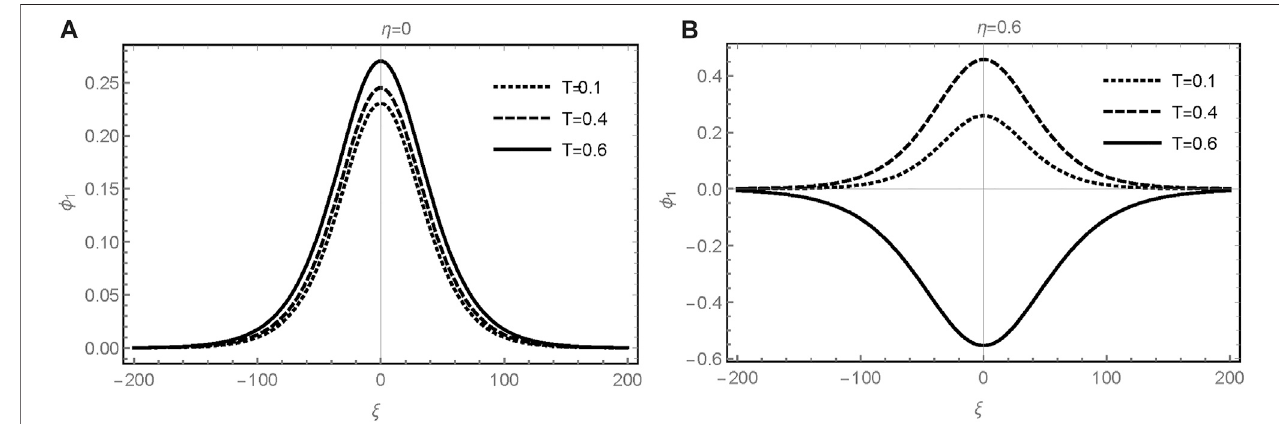
FIGURE 2 | Electric potential ϕ 1 ( ξ , τ ) of the ion-acoustic solitons is plotted across the temperature T in (A) : absence of quantized magnetic fi eld ( η (cid:1) 0) and (B) : quantized magnetic fi eld ( η (cid:1) 0.6). Here l Z (cid:1) 0.8, l X (cid:1) l Y (cid:1)